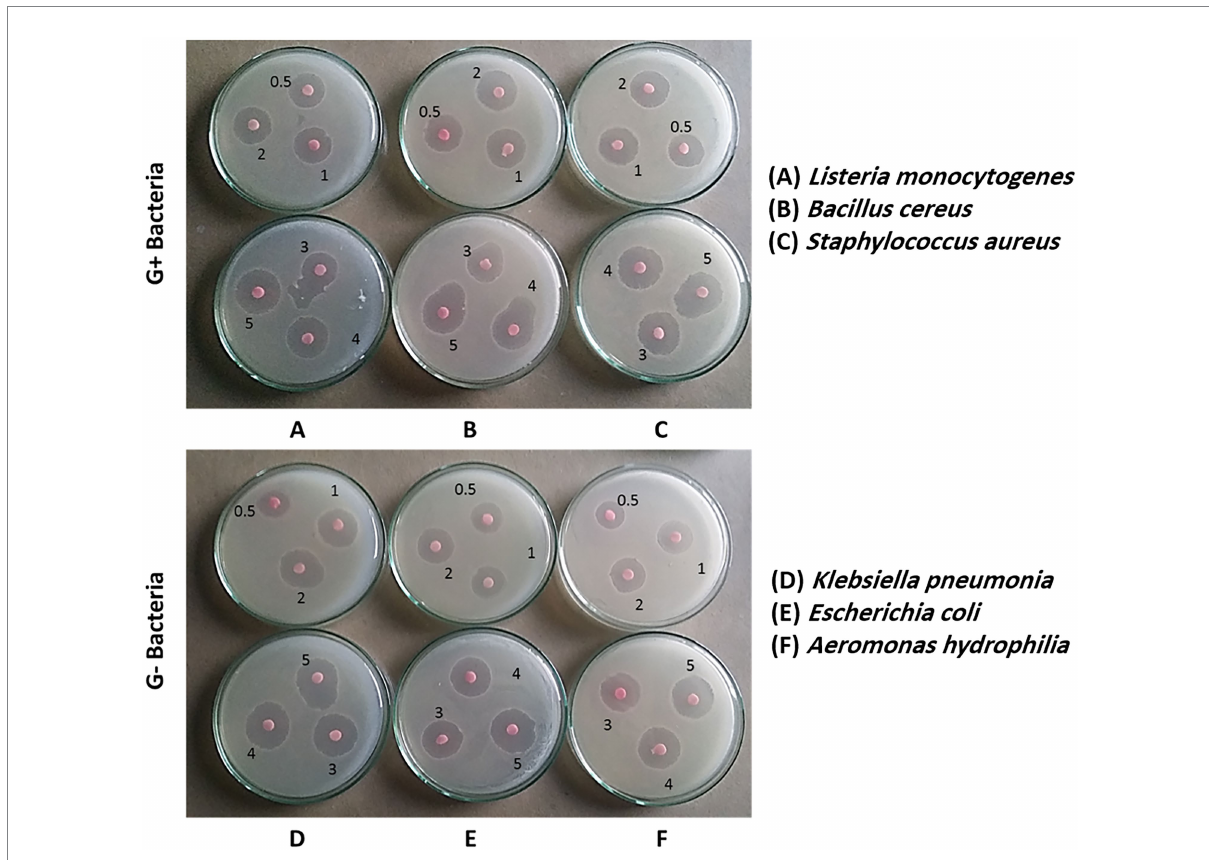
FIGURE 6 Antibacterial activity of biosynthesized selenium nanoparticles (BioSeNPs) suspensions (0.5–5.0 μ g ml − 1 ) fabricated by Bacillus subtilis AS12 against pathogenic Gram-positive bacteria (G+ bacteria) and Gram-negative bacteria (G − bacteria).